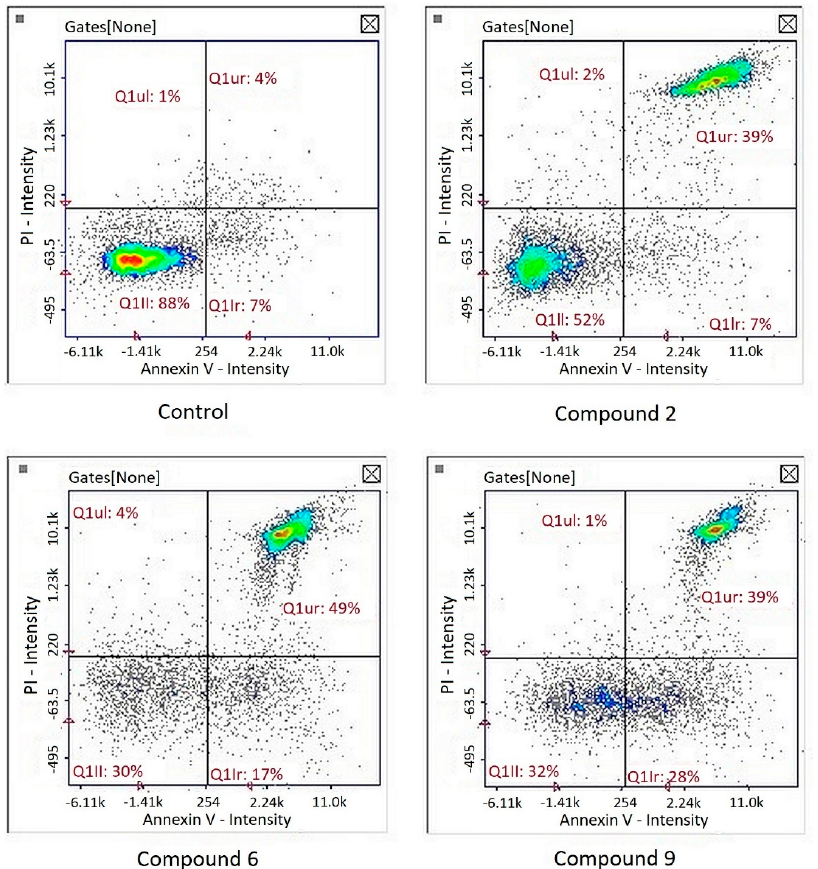
Figure 5. Detection of apoptotic and necrotic cells on the representative histograms in cultures of melanoma line G-361 after 24 h treatment with compounds PK2, PK6 and PK9 in concentrations corresponding to appropriate IC 50 values or DMSO as a vehicle in control culture, using image cytometry (propidium iodide and Annexin V-FITC staining). Q1II, normal cells; Q1Ir, early apoptotic cells; Q1ur, late apoptotic cells; Q1uI, necrotic cells.